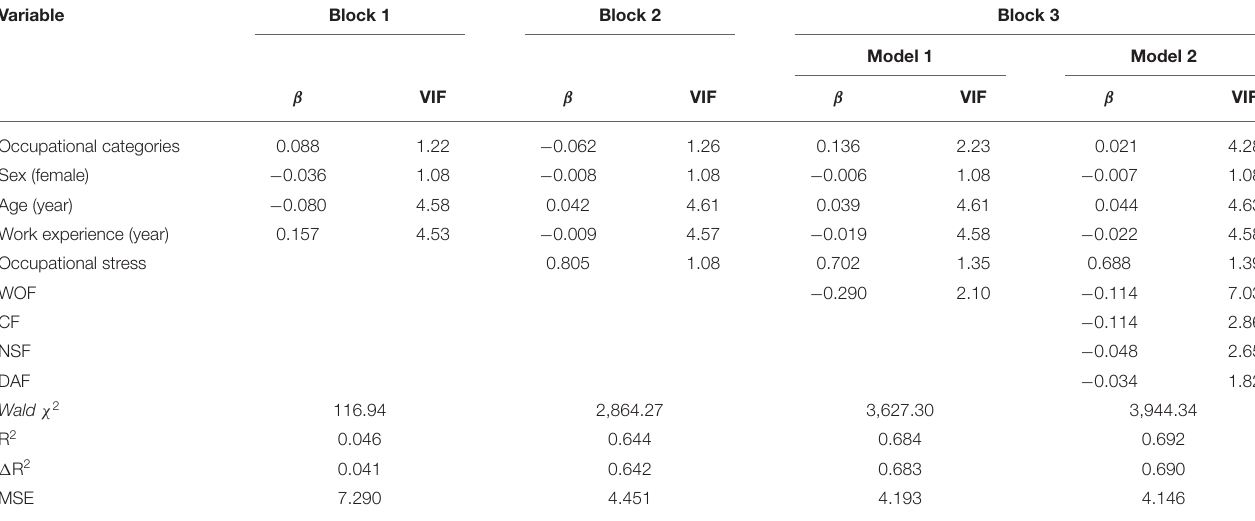
TABLE 3 | Hierarchical multiple regression analysis of the association of occupational stress and WOF with depression symptoms.